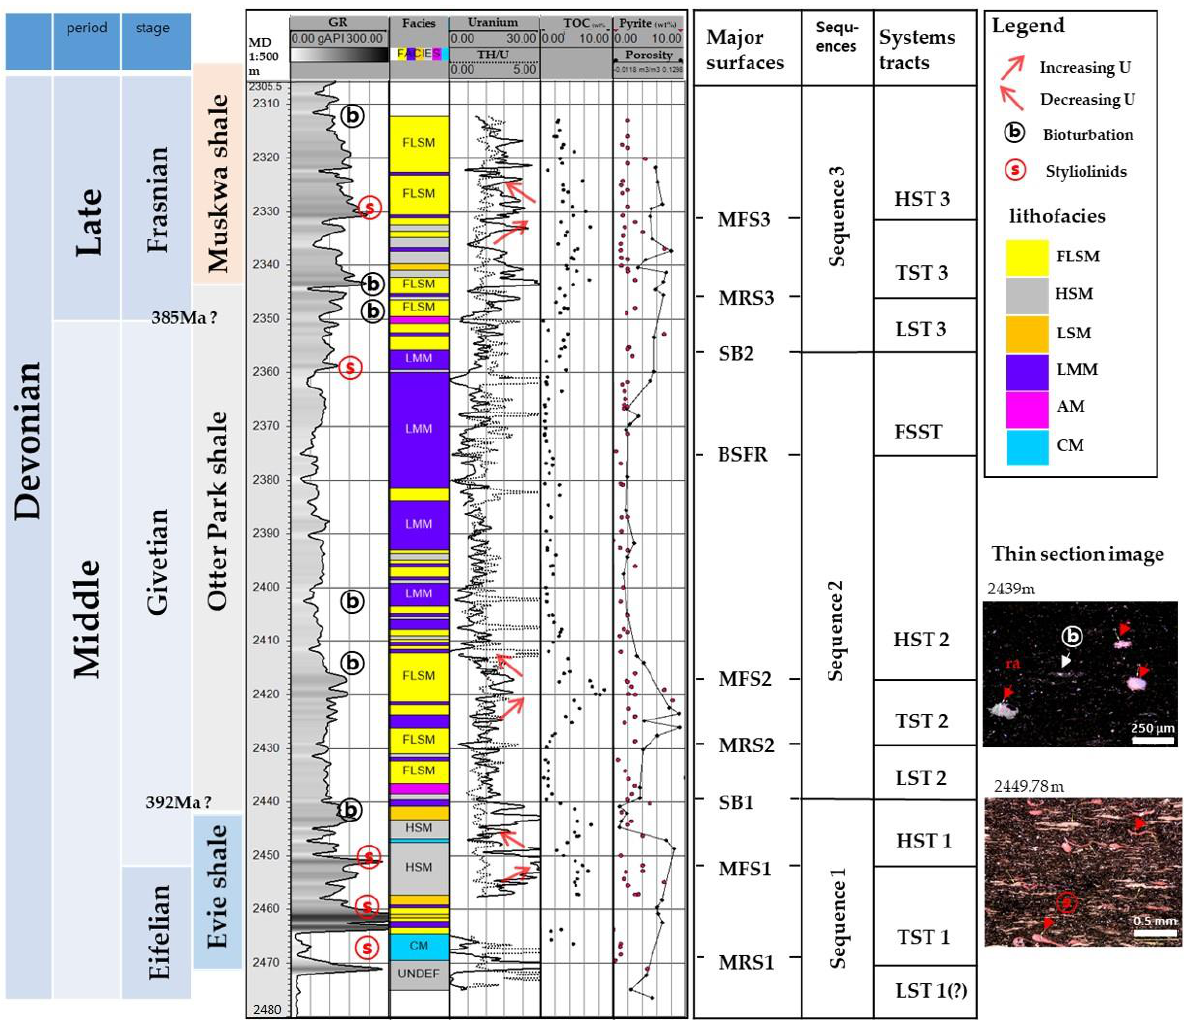
Figure 4. Sequence stratigraphic interpretation of Well A that is correlated with the depositional sequences of [12]. GR: natural gamma ray. Th/U and U: derived from the spectral gamma ray log. TOC points: geochemical analysis, Pyrite: XRD data, porosity, and core facies (see the legend for